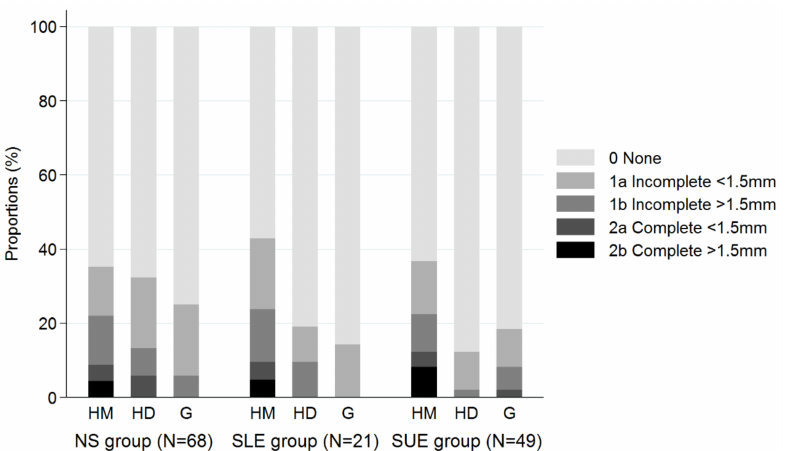
Figure 2. Radiological observation of radiolucent lines (RLL) appearance 5 years after RSA implanta- tion. HM = Humeral metaphysis; HD = Humeral diaphysis; G = Glenoid.